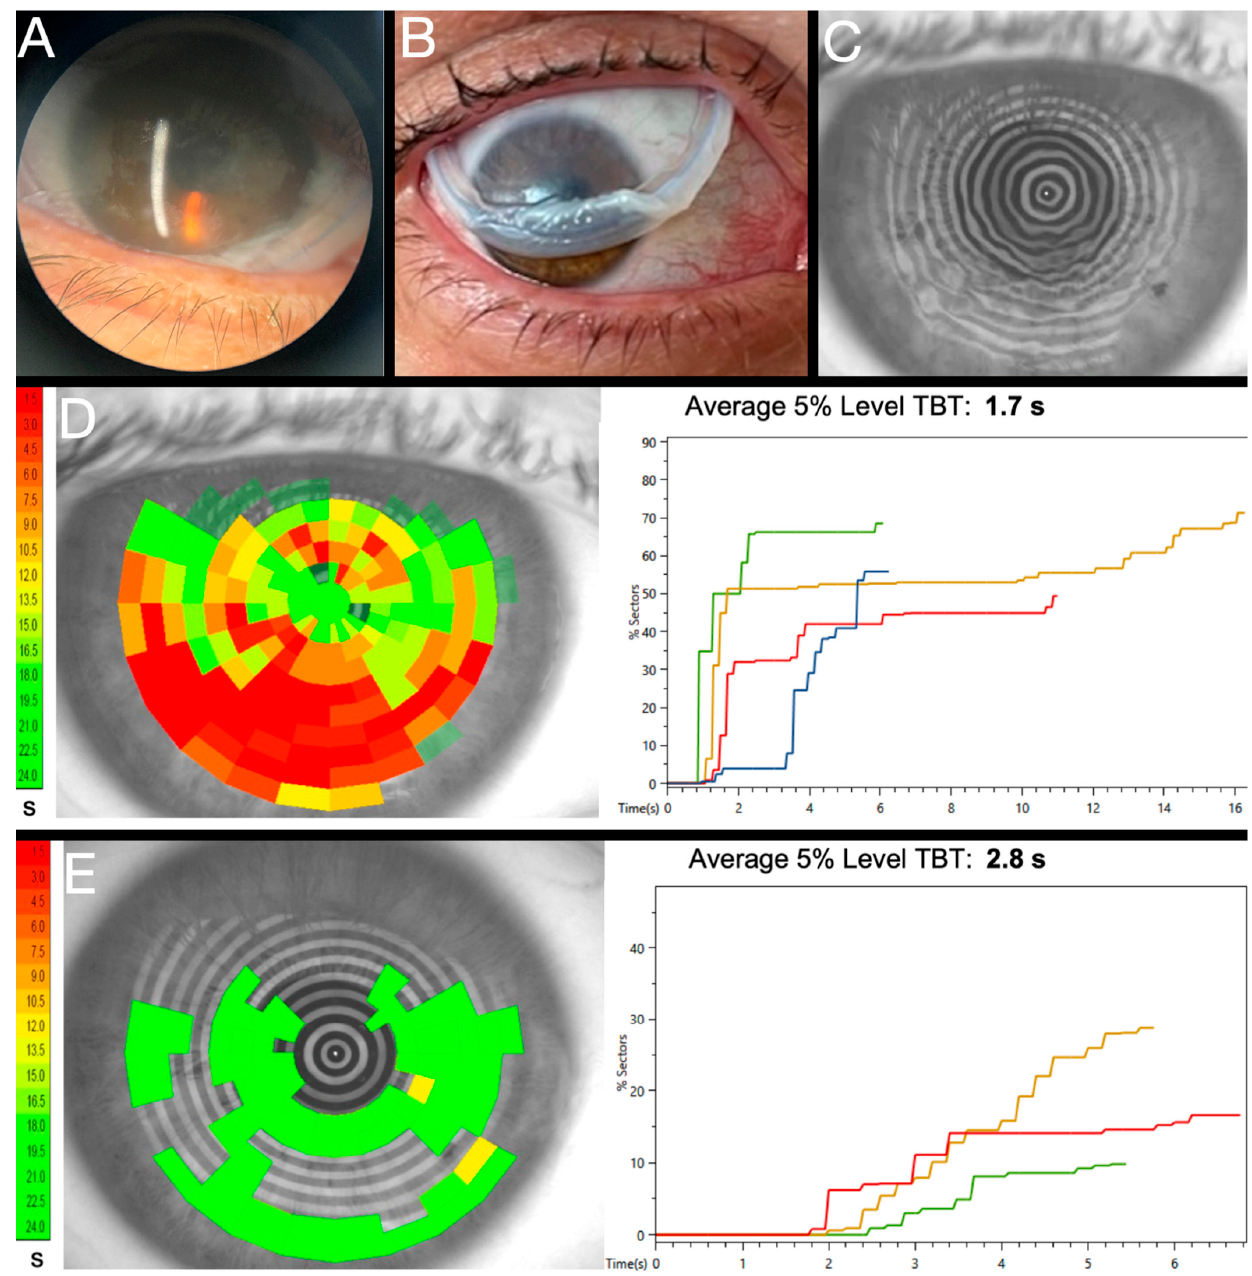
Figure 5. Prokera for preoperative STODS mitigation ( A ) demonstrates a view at the slit-lamp of standard Prokera placement (Note: even in best case scenario retaining ring presses on cornea). ( B ) Prokera has ridden up on cornea therapy inducing artifactual astigmatism. When immediately removed, Prokera leaves a film on the cornea ( C ) that interferes with the mires and paradoxically results in a worsened NITBUT ( D ) as compared to prior to insertion ( E